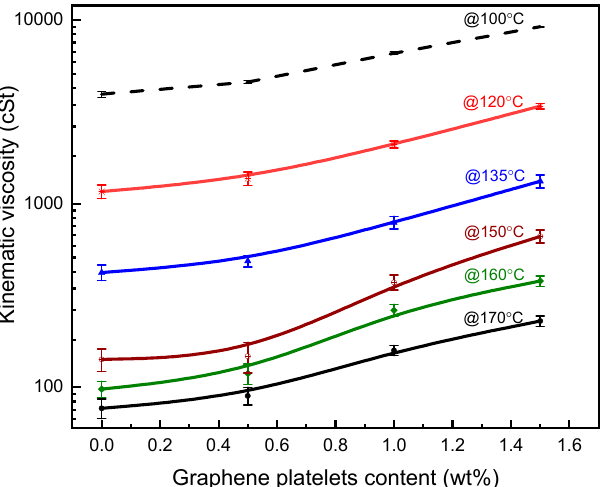
Figure 6. Kinematic viscosity of unmodified asphalt and its graphene platelets nanocomposites within temperature range 100–170 °C.